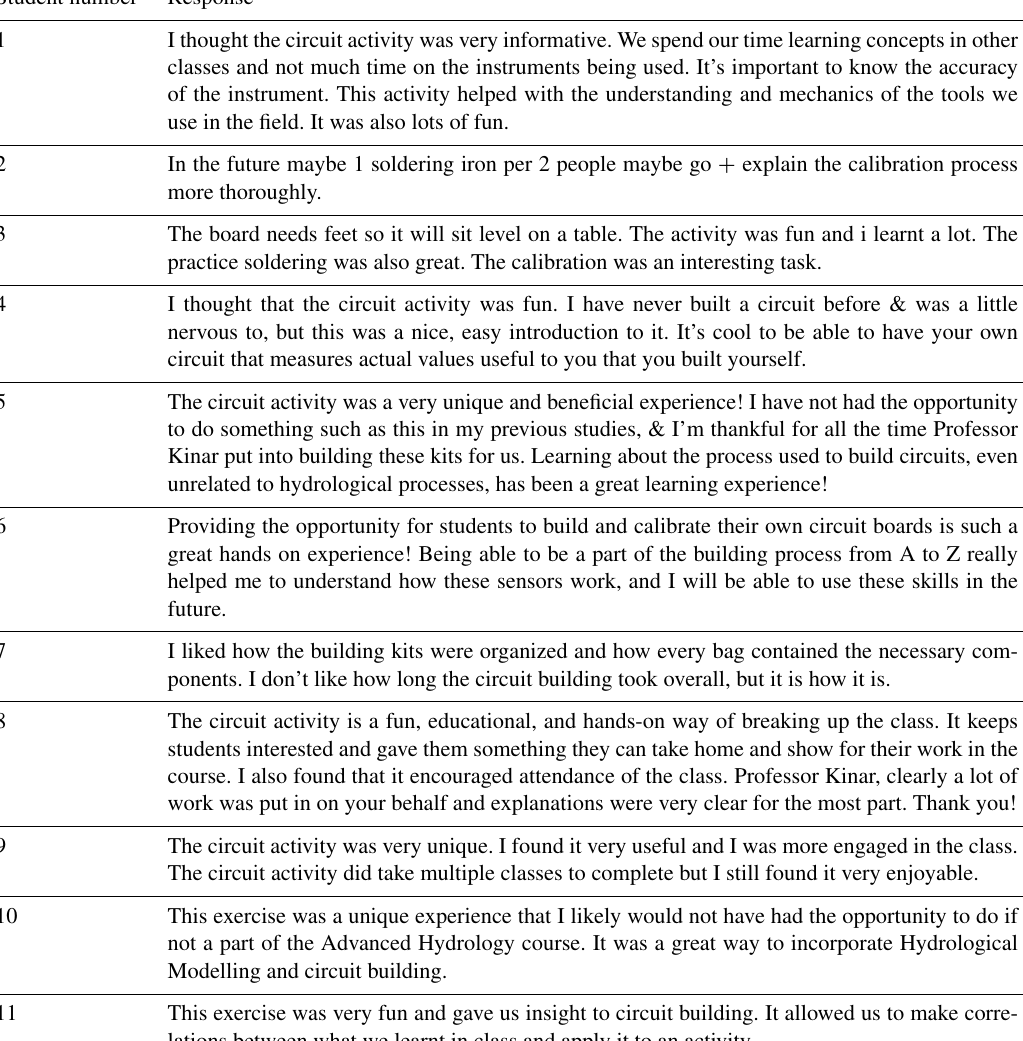
Table 3. Student open-ended feedback responses transcribed as written by the students. The student number in the first column of the table was only used for analysis and is not intended to covey a ranking of responses. Moreover, the student number cannot be used to identify a student in the class. The responses in the table below are also available for digital download (Sect.